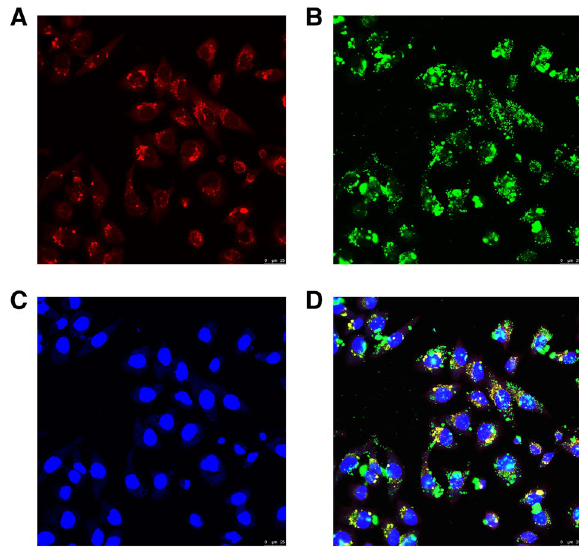
Fig. 5 Intracellular uptake of EVs in Hosepic cells. A EVs were labeled in red. B Cytosols were labeled in green. C Nuclei were labeled in blue. D The merged